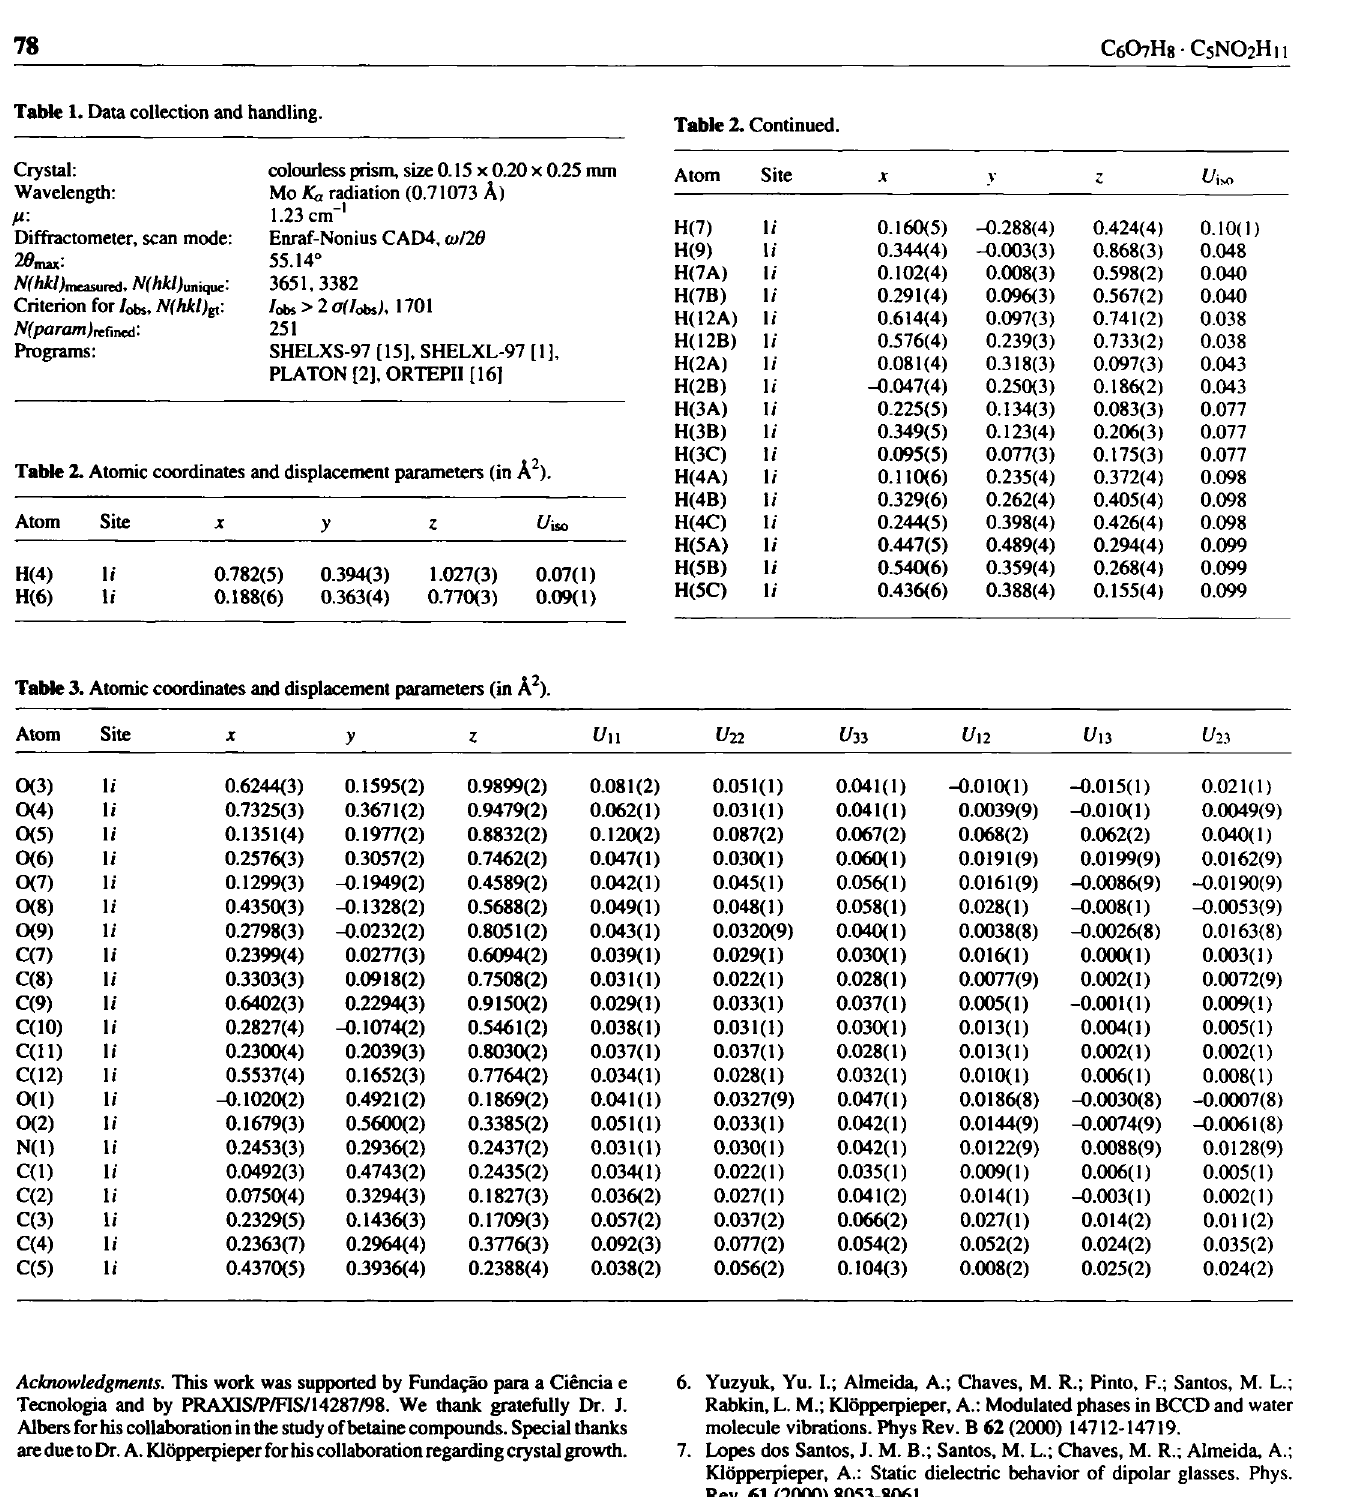
Table 1. Data collection and handling.